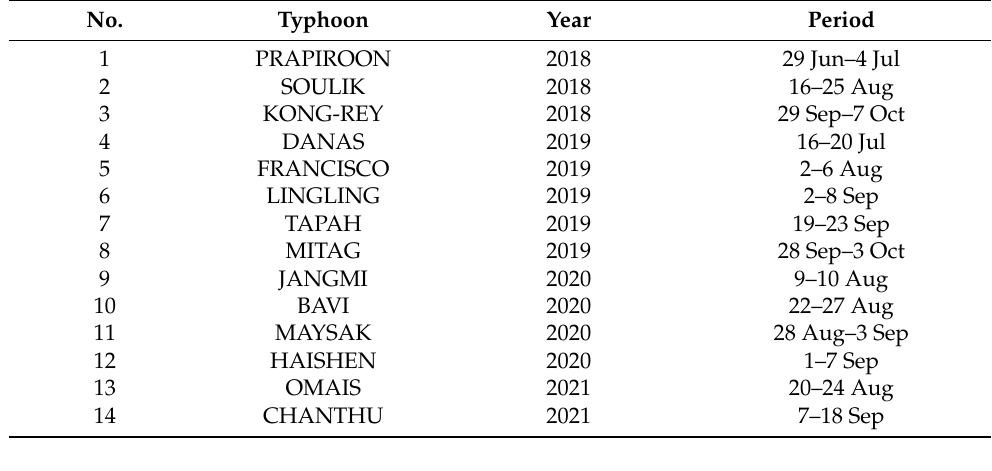
Table 1. List of typhoons that affected the Korean Peninsula between 2018–2021.